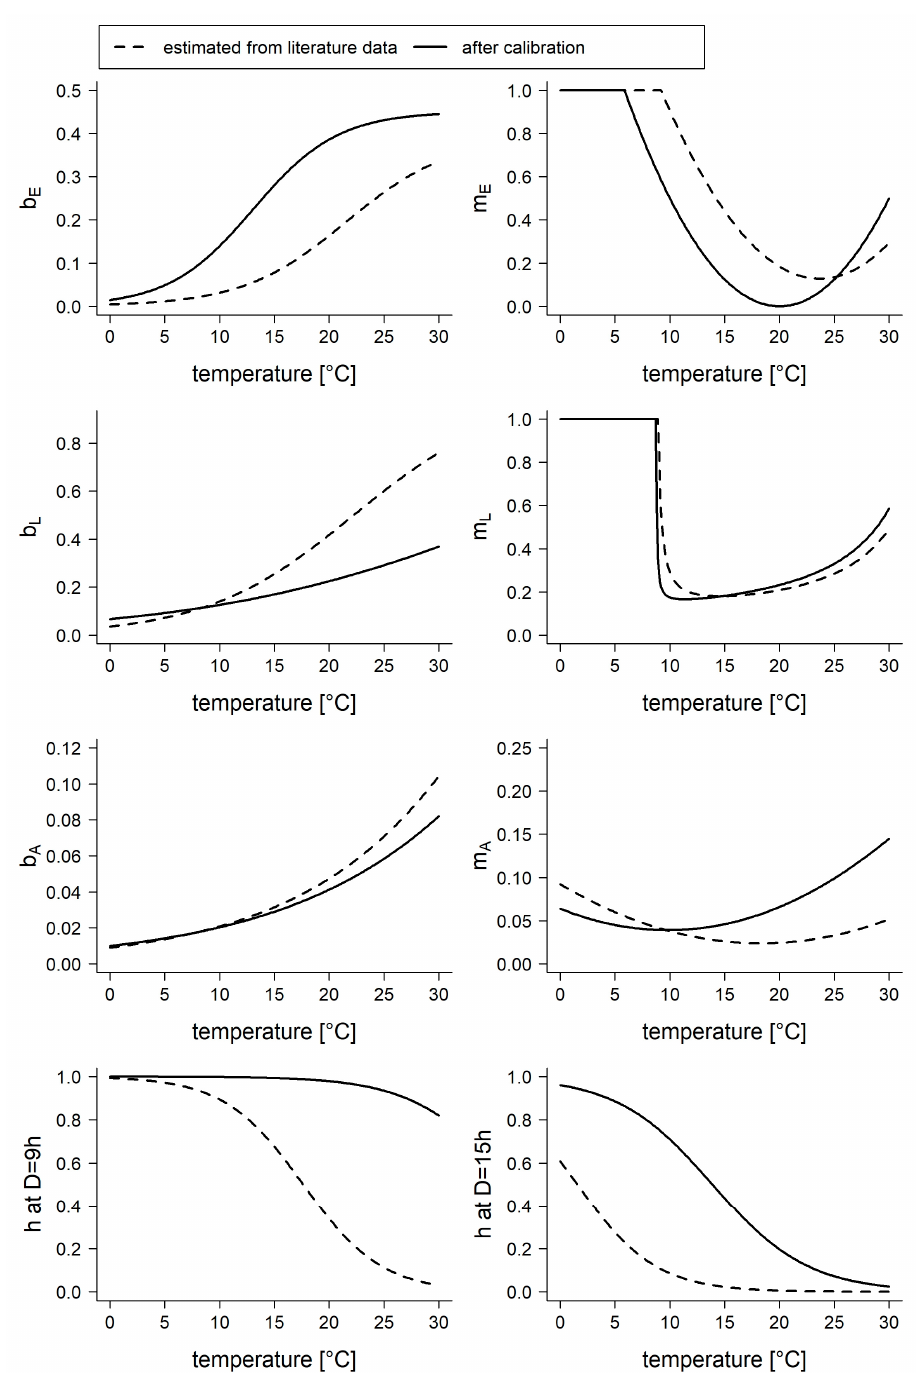
Figure 4. Functions used to describe the transition parameters (see Table 1). Dashed lines represent the estimated functions fitted to literature values ( mL multiplied by a factor of 10), and solid lines represent the functions after calibration with the training data set.